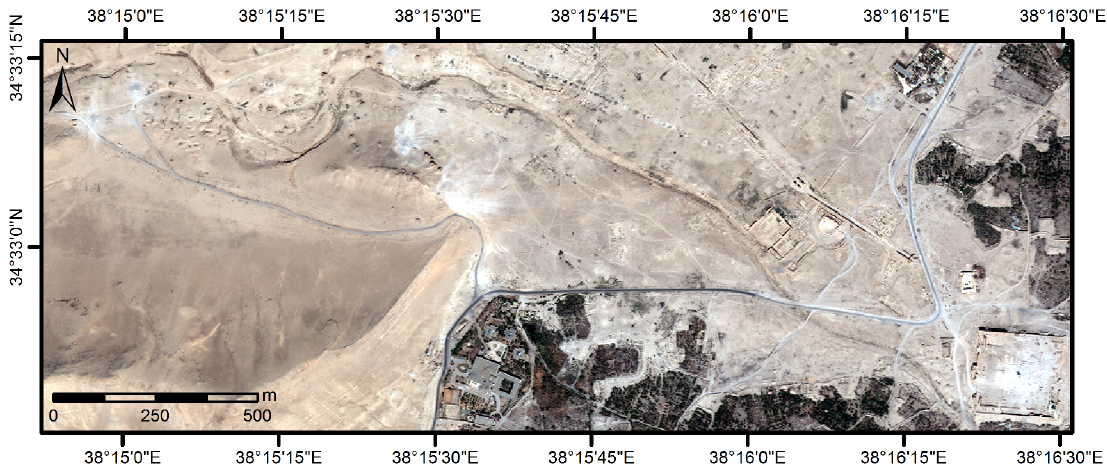
Figure 5. Subset of the WorldView-2 image acquired on the 2 September 2015 ( c (cid:13) European Space